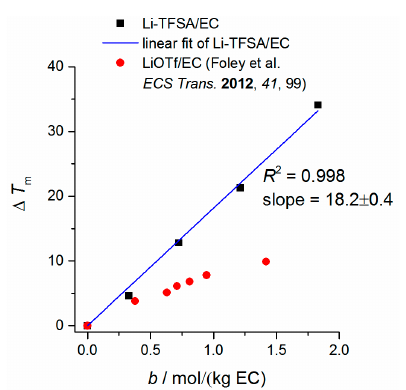
Figure 5. Relative depression of the freezing point vs. molality of EC/Li-TFSA compared to results of EC/LiOTf binary mixture from Reference [37]. The result of the linear fitting is depicted as blue line ( Δ T m = 0 at b = 0 was fixed).